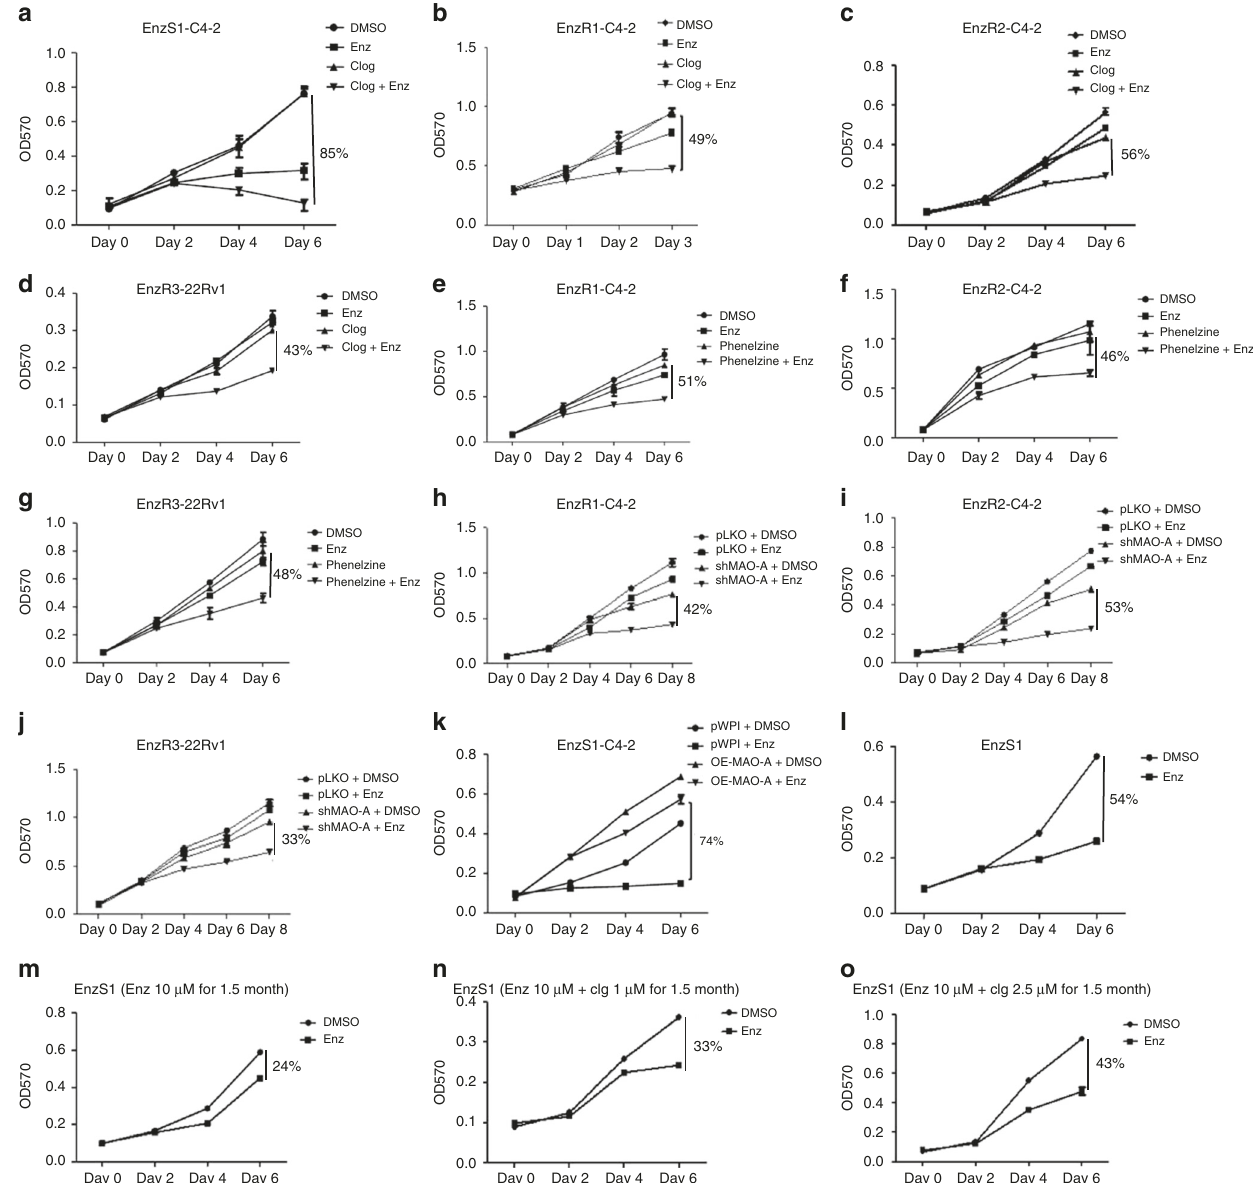
Fig. 2 Targeting MAO-A resensitizes EnzR cells to Enz and suppresses EnzR cell growth. a EnzS1-C4-2 cells were treated with/without (w/o) 10 μ M Enz and 5 μ M clorgyline, and cell viability analyzed by MTT assay; ( n = 3 biological independent samples); p = 0.03. b – d EnzR1-C4-2, EnzR2-C4-2, and EnzR3- 22Rv1 cells, respectively, were treated (w/o) 10 μ M Enz and 5 μ M clorgyline, and cell viability was analyzed by MTT assay; ( n = 3 biological independent samples); p = 0.02 for b , p = 0.03 for c , and p = 0.03 for d . e – g EnzR1-C4-2, EnzR2-C4-2, and EnzR3-22Rv1 cells, respectively, were treated w/o 10 μ M Enz and 5 μ M phenelzine, and cell viability was analyzed; ( n = 3 biological independent samples); p = 0.03 for e , p = 0.04 for f , and p = 0.03 for g . h – j The EnzR1-C4-2, EnzR2-C4-2, and EnzR3-22Rv1 cells with pLKO or shMAO-A cells were treated w/o Enz and cell viability was analyzed; ( n = 3 biological independent samples); p = 0.02 for h , p = 0.02 for i , and p = 0.01 for j . k MAO-A was overexpressed (oeMAO-A) in EnzS1-C4-2 cells and then the cells treated w/o Enz and cell viability was analyzed; ( n = 3 biological independent samples); p = 0.002 for k . l EnzS1-C4-2 cells were treated w/o 10 μ M Enz and cell viability was analyzed; ( n = 3 biological independent samples); p = 0.001. m EnzS1-C4-2 cells were fi rst treated (w/o) 10 μ M Enz for 1.5 months. And then the cells were seeding and the cell viability under 10 μ M Enz treatment was analyzed by MTT assay; ( n = 3 biological independent samples); p = 0.02. n , o EnzS1-C4-2 cells were treated w/o 10 μ M Enz and 1 μ M ( n ) or 2.5 μ M ( o ) clorgyline (clg) for 1.5 months. And then the cell viability under 10 μ M Enz treatment was analyzed; ( n = 3 biological independent samples); p = 0.01 for n and p = 0.01 for o . Data represent the mean ± SEM, error bars represent SEM. p -value was determined by two-tailed paired t